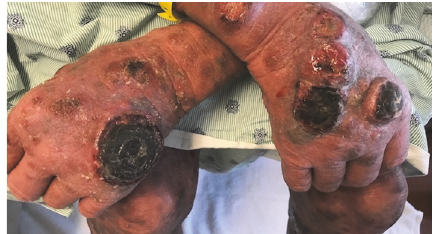
Figure 2: Ulcerated tumors bilaterally on hands.